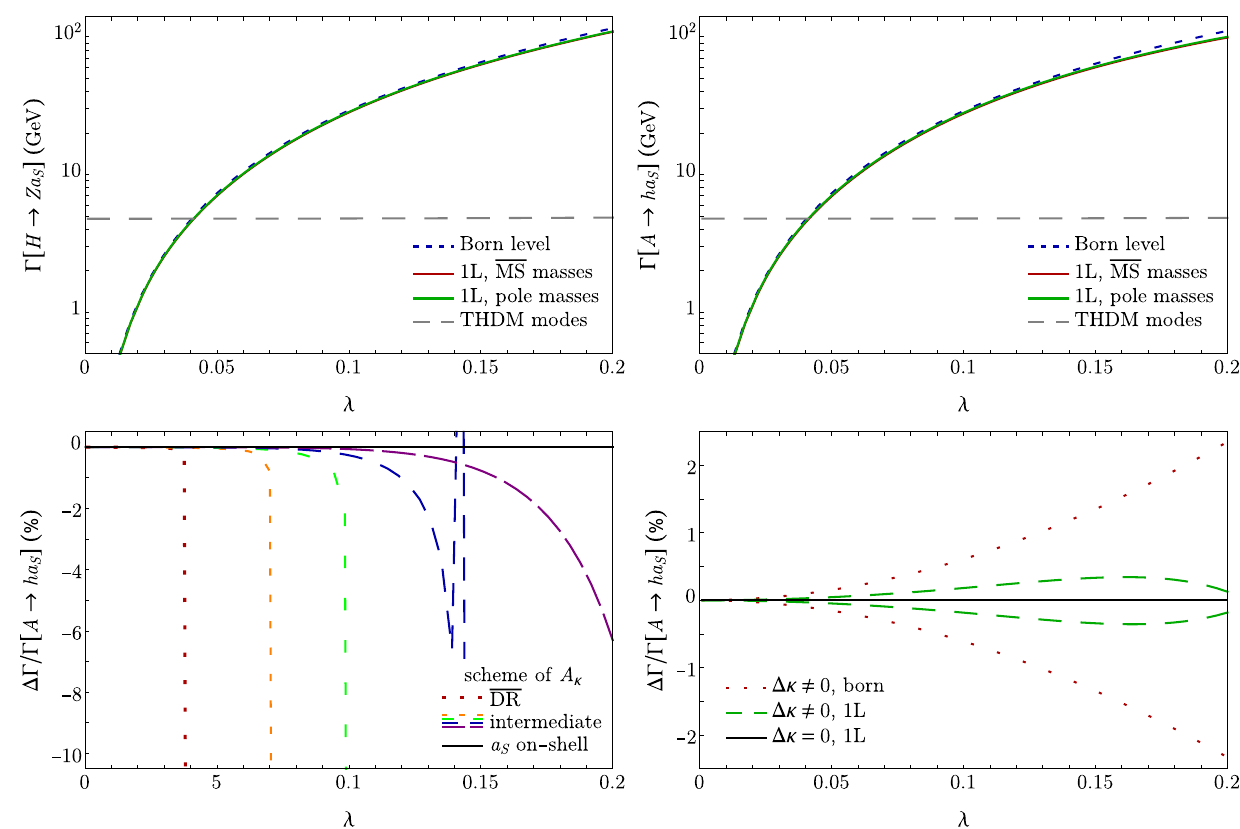
] (right) as a function of λ at tree-level (blue dashed), or (cid:6) [ A → ha Fig. 4 SU ( 2 ) L -conserving two-body decays in an NMSSM scenario S ! = λ 1L (solid curves) with varying definitions of the quark masses (green = 300GeV (and h with κ , M H ± = 3TeV and M a S kinemati- S vs. red). Second row: Behavior of (cid:6) [ A → ha S ] under variations of the cally inaccessible). First row: Decay widths (cid:6) [ H → Za S ] (left) and renormalization scheme for A κ (left) or κ